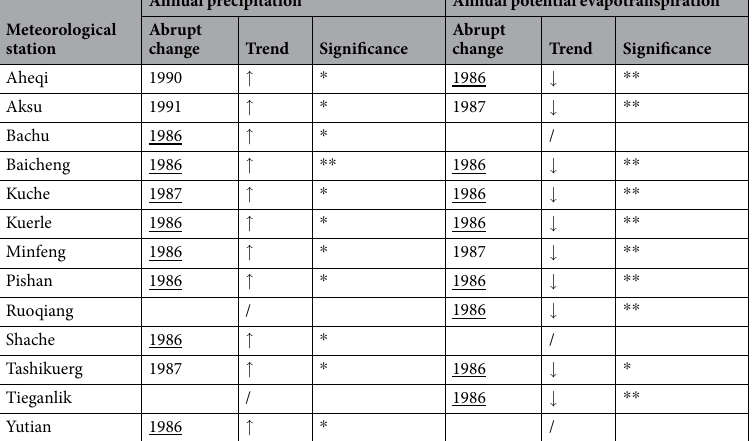
Table 1. Summary statistics for the annual precipitation and potential evapotranspiration analysis at 13 stations in the Tarim River Basin during 1960~2015. Notes: In the Pettitt test, ** indicates significant level of 0.1%, * indicates significant level exceeds 5%, ↑ ( ↓ ) indicates an increasing(decreasing) trend, and/indicates unremarkable change trend.